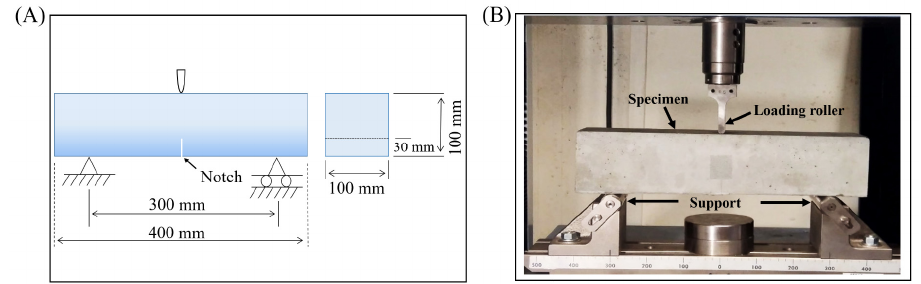
Figure 2. Schematic of the notched beam ( A ) and experimental apparatus of the notched beam ( B ) under quasi-static three-point bending test.